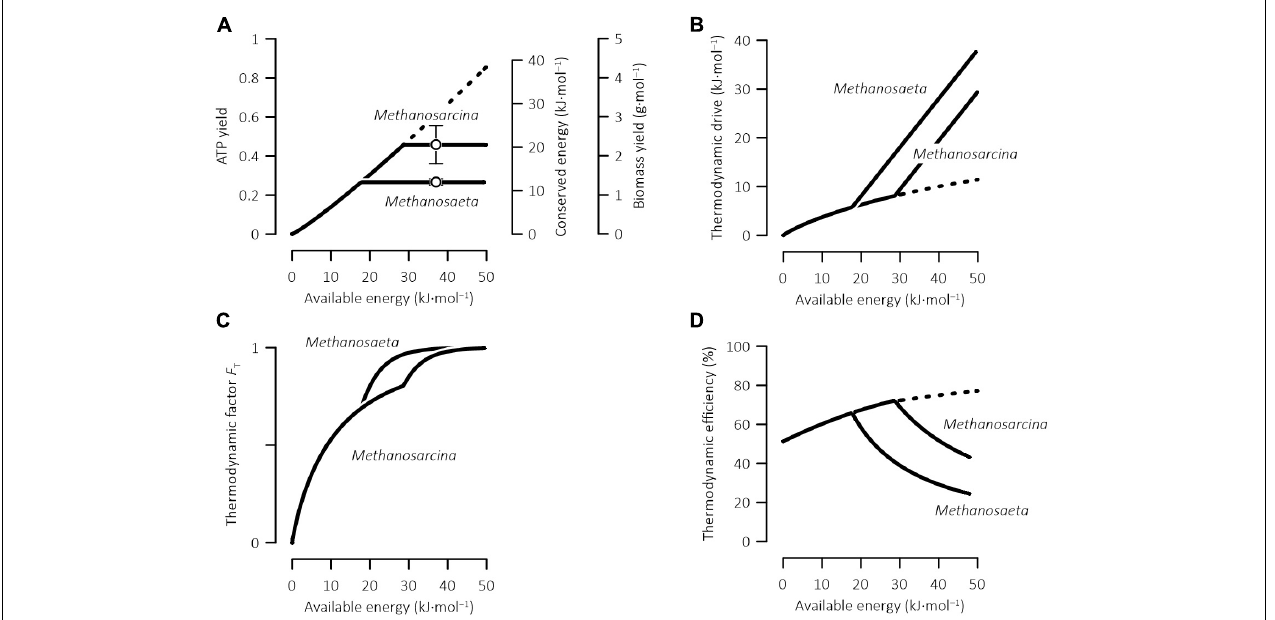
FIGURE 2 | Variations with available energy in the ATP and biomass yields, the energy conserved by ATP synthesis (A) , the thermodynamic drive (B) , the thermodynamic potential factor (C) , and the thermodynamic efficiency (D) of methanogenesis by Methanosarcina and Methanosaeta . Open symbols in panel (A) are the biomass yields determined experimentally for pure cultures and error bars show standard deviations (see Table 1 ); solid lines are calculated according to Eqs 1, 4, 20, 21; dashed lines indicate that the calculated values exceed those of laboratory cultures and may not be biochemically feasible.